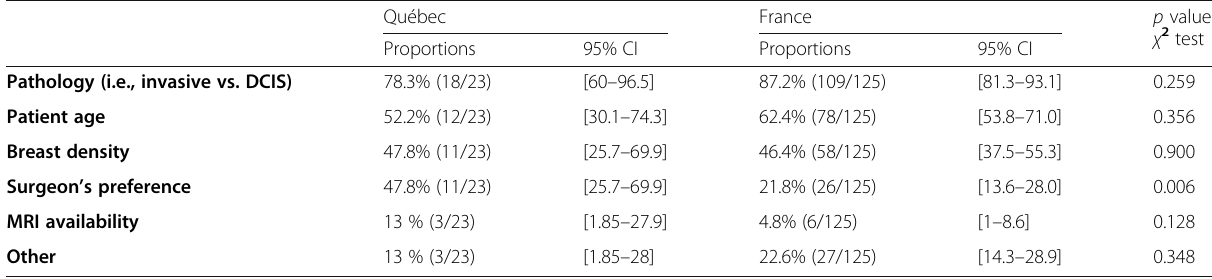
Table 6 Most important factors influencing your decision as to whether or not to recommend a preoperative breast MRI? (select all applicable